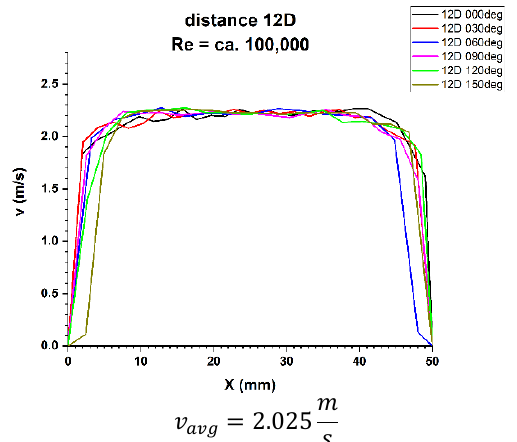
Figure 26. Velocity profiles at a distance 12D from the disturbance with marked cross-sections for Re ≅ 100,000-The LDA measurement taken in the ultrasound wave